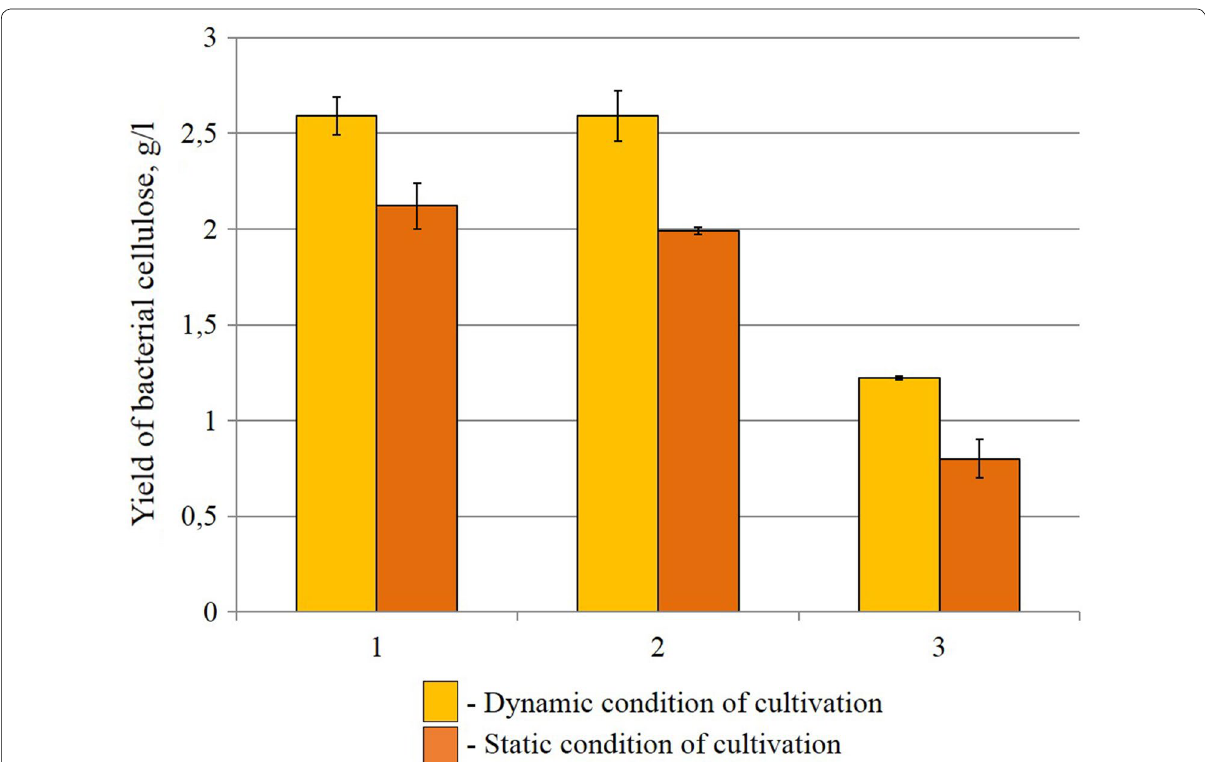
Fig. 5 The yield of bacterial cellulose obtained in static and dynamic conditions of semi-continuous cultivation using immobilized